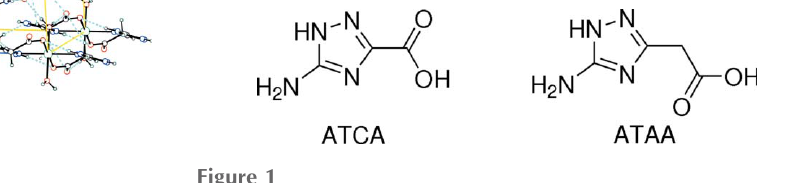
Figure 1 Structural formulas of 5-amino-1 H -1,2,4-triazole-3-carboxylic acid ( ATCA ) and 2-(5-amino-1 H -1,2,4-triazol-3-yl)acetic acid ( ATAA